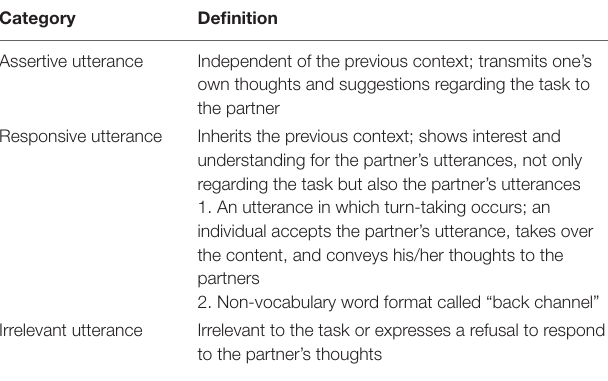
TABLE 2 | Categories and definitions of